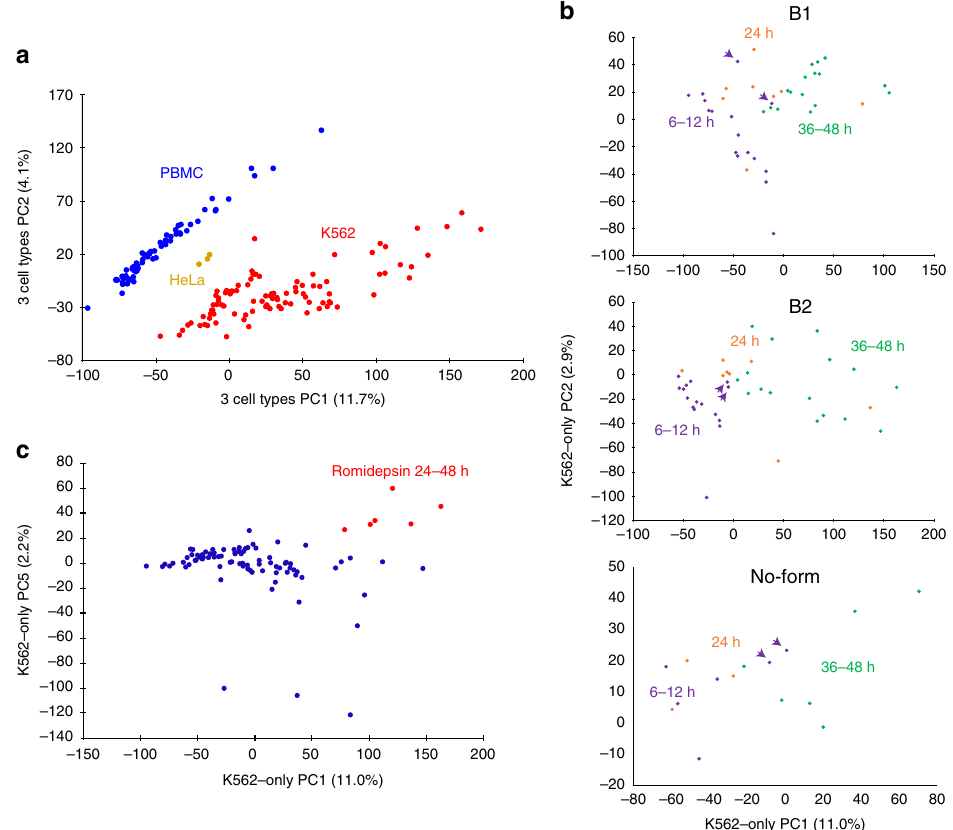
Fig. 4 Association of SSB “ breakome ” with biological states. Results of PCA analyses based on pro fi les of breaks in genic regions detected using SSiNGLe-ILM. a clustering of three cell types — 95 K562 samples (two biological replicas and no-formaldehyde samples), HeLa (three biological replicas) and 66 PBMC samples. b Separation of early (6 – 12 h), middle (24 h) and late (36 – 48) time points of treatments in two biological replicas (B1 and B2) and no-formaldehyde K562 samples. Purple arrowheads indicate early time points of etoposide treatments. c Clustering of middle-late time points of K562 romidepsin treatments. PCA was performed on all three cell types ( a ) or just the K562 samples ( b , c